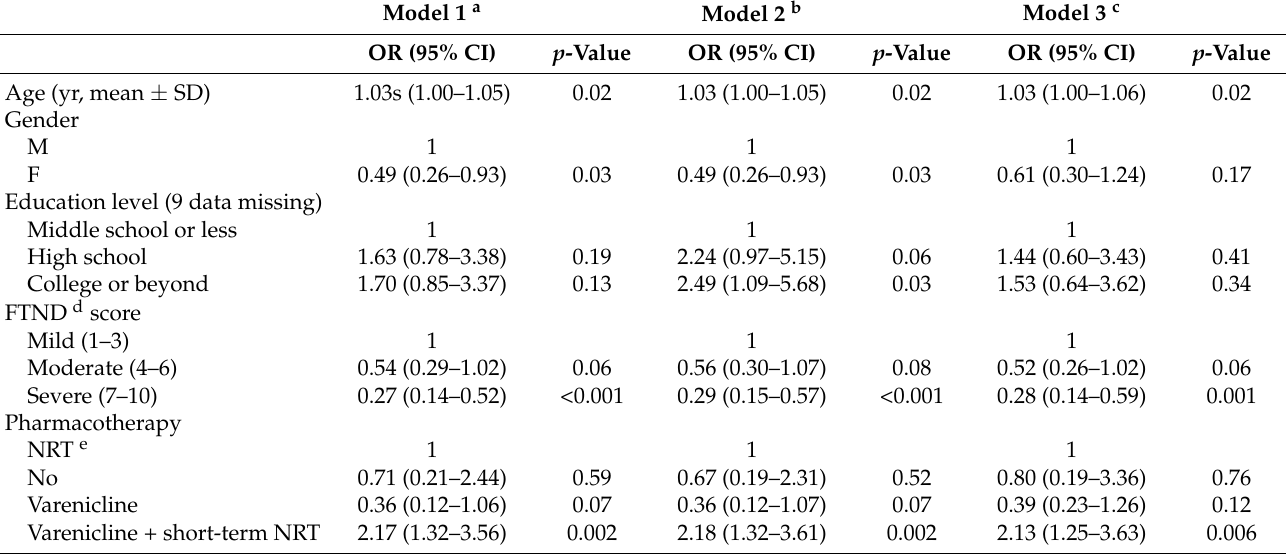
Table 4. Multivariable logistic regression analysis of factors associated with 3 months smoking